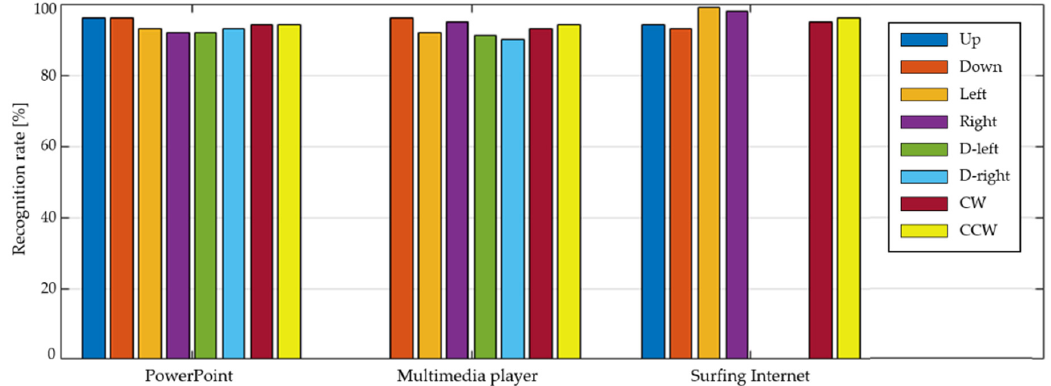
Figure 9. The recognition rates each function in three application programs.